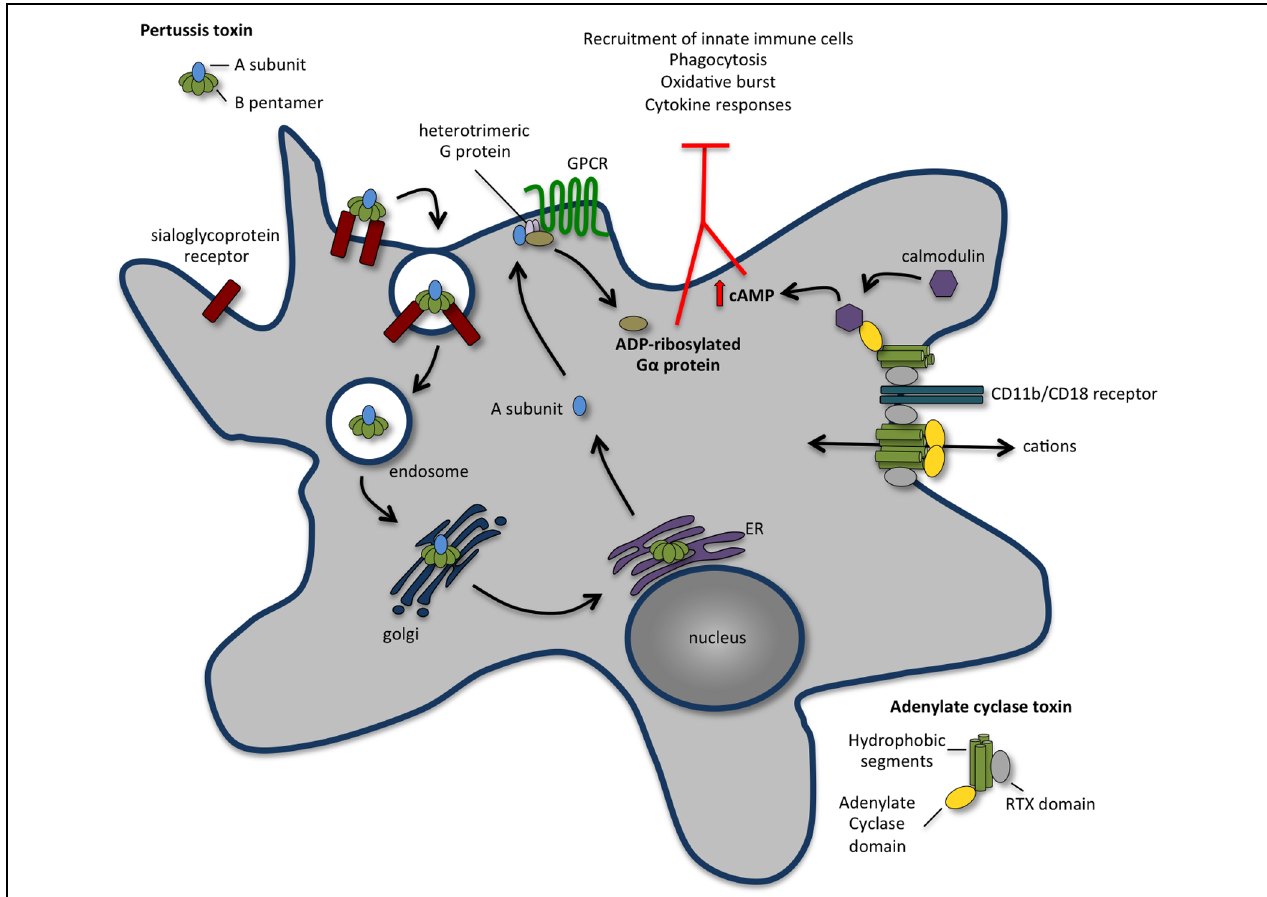
FIGURE 1 | The concerted action of pertussis toxin (PT) and adenylate cyclase toxin (ACT) annihilates recruitment and function of innate immune cells. Following binding to a sialoglyprotein receptor, PT is endocytosed and retrogradely transported to the endoplasmic reticulum (ER). From the ER, the A subunit is delivered into the cytosol and travels to the plasma membrane, where it ADP-ribosylates the alpha-subunit of heterotrimeric G proteins, perturbing their regulatory functions and leading to an increase in the cAMP concentration that contributes to the early suppression of inflammatory cytokine production and inhibits the recruitment of immune cells to the site of infection. ACT binds with high affinity to CD11b/CD18 receptor [also known as complement receptor 3 (CR3) or macrophage-1 antigen (Mac-1)] present at the surface of macrophages, neutrophils, and dendritic cells. Upon binding, ACT integrates the membrane of target cell in two different conformations: a translocation precursor that relocalises at lipid raft domains from where the adenylate cyclase activity translocates directly to the cell cytoplasm; and a pore precursor that oligomerises and permeabilises the cells causing ion concentration imbalance. Binding of calmodulin stimulates the adenylate cyclase, leading to an increase in intracellular levels of cAMP. The activity of ACT inhibits complement-mediated phagocytosis, inhibits the production of pro-inflammatory cytokines and interferes with immune cell